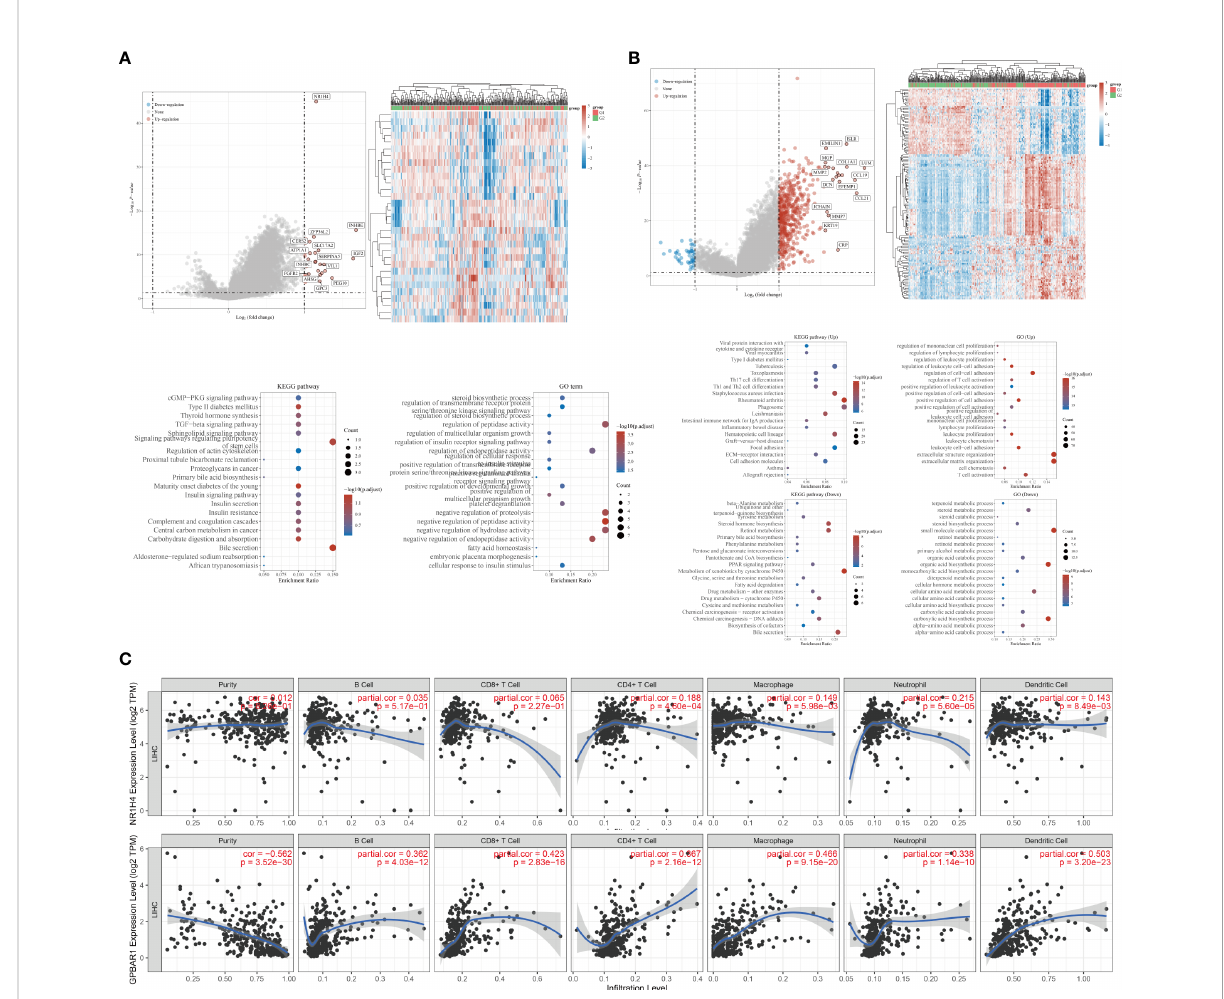
FIGURE 3 Potential biological mechanisms and immune in fi ltration levels of bile acids- activated receptors. (A) Volcano map of DEGs, heatmap of DEGs, and the Gene Ontology (GO) and Kyoto Encyclopedia of Genes and Genomes (KEGG) analyses for high and low FXR expression group based on the TCGA dataset. (B) Volcano map of DEGs, heatmap of DEGs, and the Gene Ontology (GO) and Kyoto Encyclopedia of Genes and Genomes (KEGG) analyses for high and low TGR5 expression group based on the TCGA dataset. (C) Correlations between FXR, TGR5 and immune in fi ltration levels validated with the TIMER database,